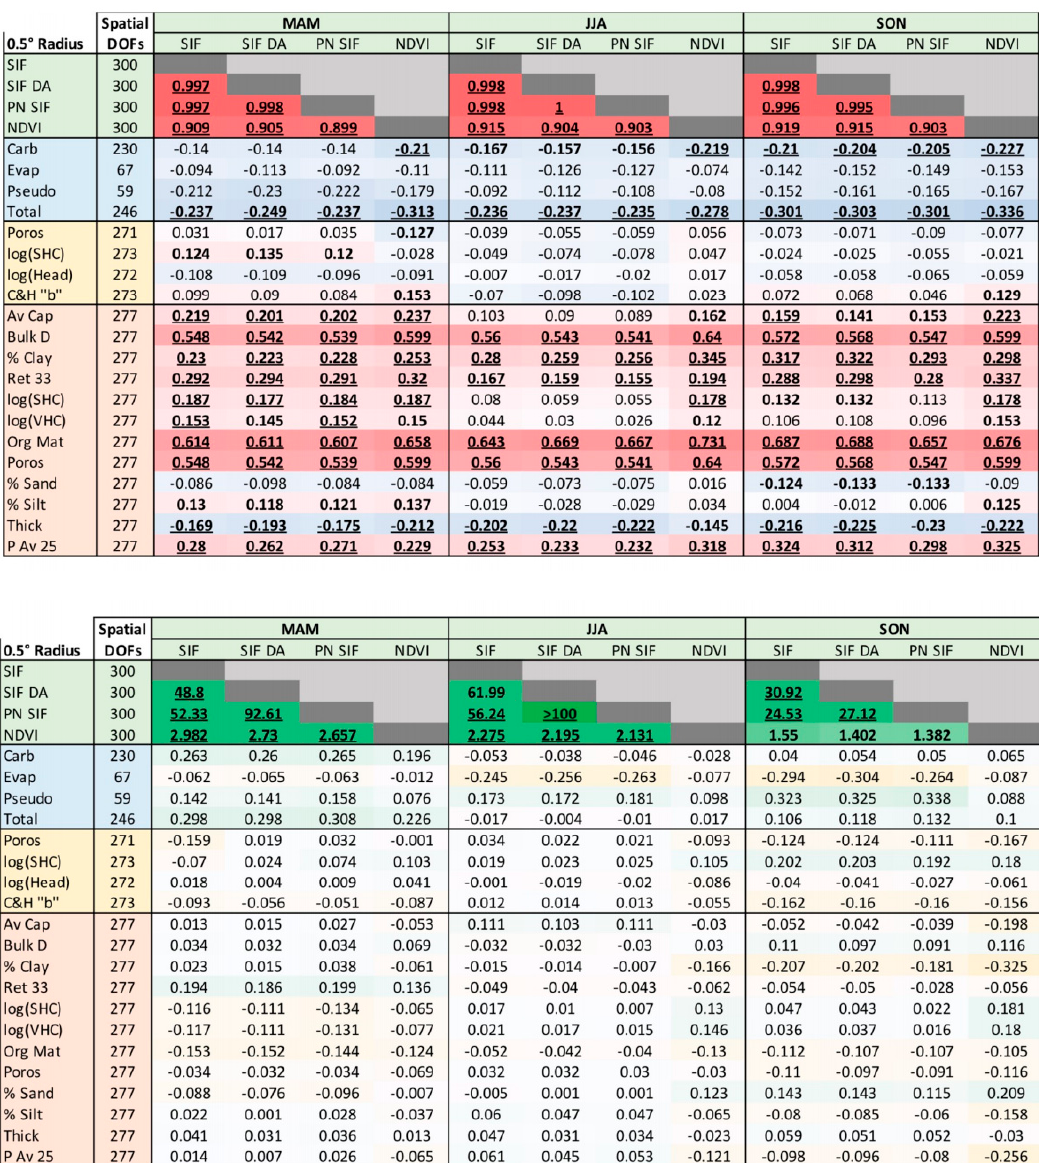
Figure 3. As in Figure 2 including seasonal (spring = March–April–May “MAM”; summer = June– July–August “JJA”; fall = September–October–November “SON”) SIF parameters.